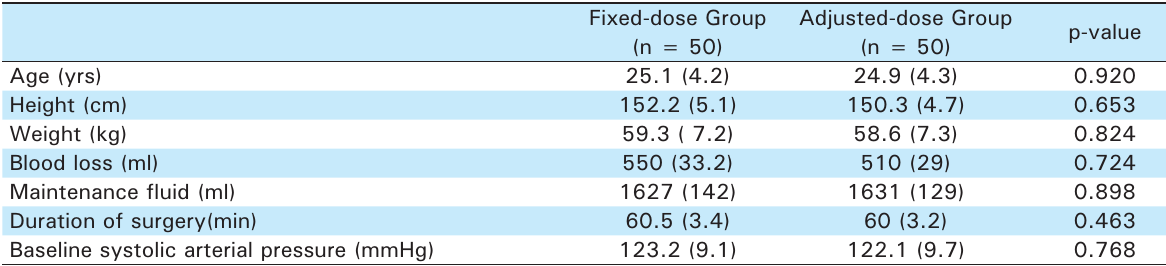
Table 2. Patient characteristics, surgical data and baseline